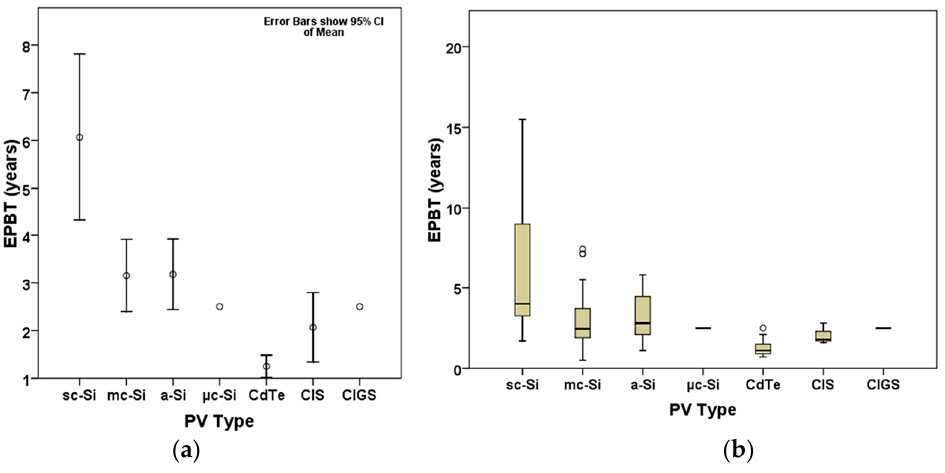
Figure 2. EPBT periods for PV electricity generation systems: ( a ) mean ± 95% CI error bars and ( b ) quartile box plots. Table 4. EPBT period (years) statistics for PV electricity generation systems.